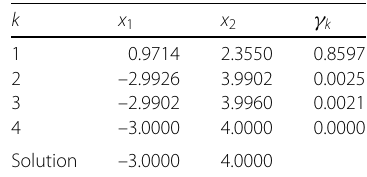
Table 1 Iterative solution for Ex.